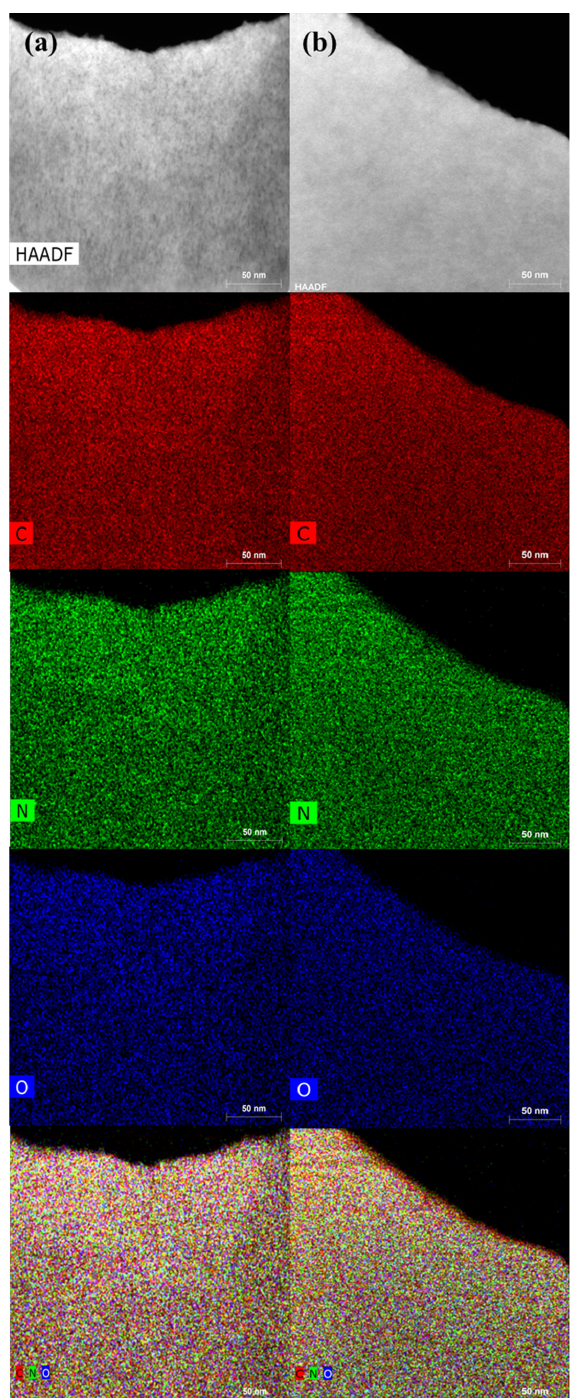
Figure 7. High-resolution transmission electron microscopy (HR-TEM) chemical mapping of carbon nanosheets ( a , b ). Red color denotes C, green N and blue O. The images at the bottom show the uniform distribution of C, N and O within the